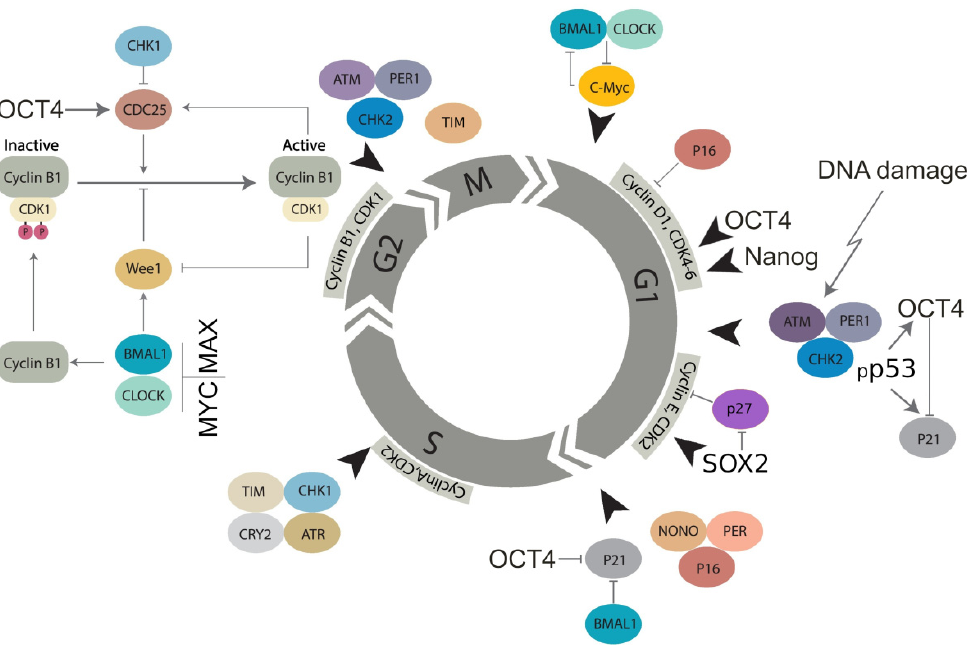
Figure 2. Molecular linkage between the regulators of the cell cycle in embryonal (cancer) stem cells with the checkpoints adapted by basic stemness transcription factors in their relationship with CDK inhibitors (not all of them are shown) and the circadian clock (adapted from [94] under Creative Commons Licence). The details of the action of the circadian clock regulators in DNA damage checkpoints and WGD are reviewed in Sections 7 and 8.